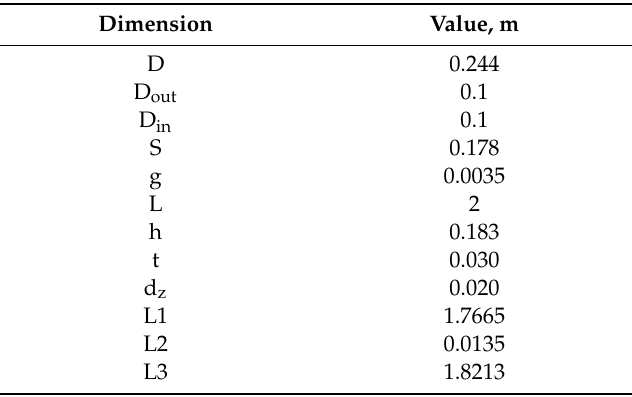
Figure 5. Geometry of the tested shell-and-tube heat exchanger (STHE) model. ( a ) Longitudinal section of the sell side; ( b ) cross-section of the shell side with the directions of velocities u and v; ( c ) location of the measuring area with direction of the velocity v in . Table 1. Detailed dimensions of the